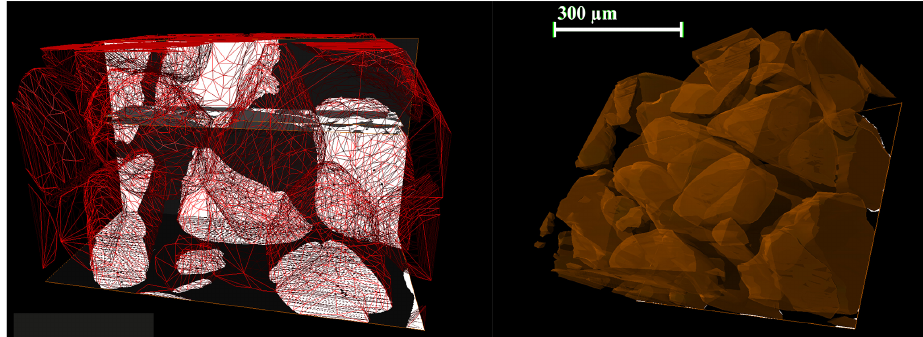
Figure 9. Surface triangulation of quartz grains and the surface view on α -scale